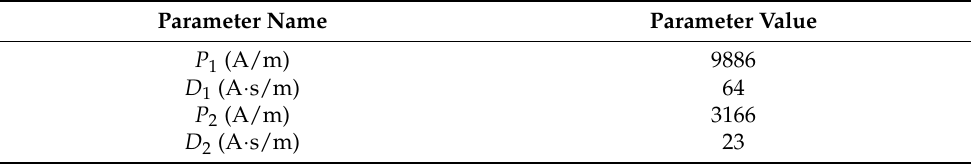
Table 4. The designed PD-gains.